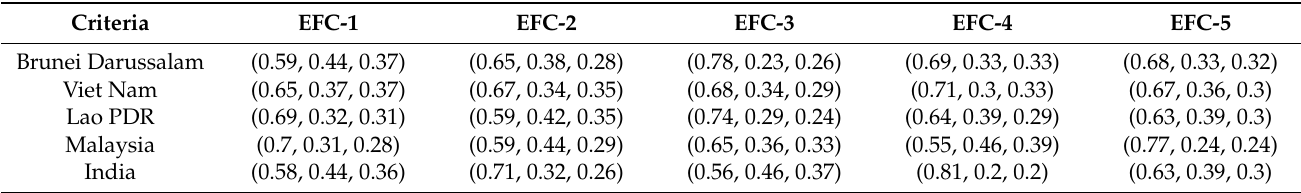
Table A6. The SF decision